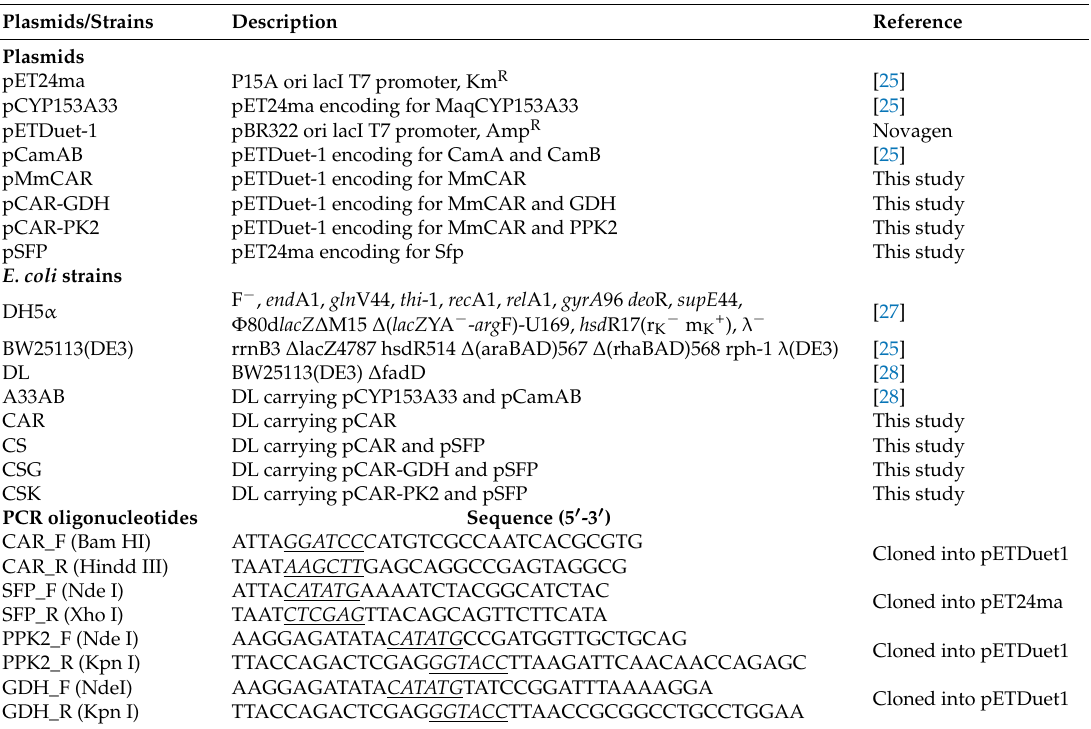
Table 1. Plasmids and strains used in this study